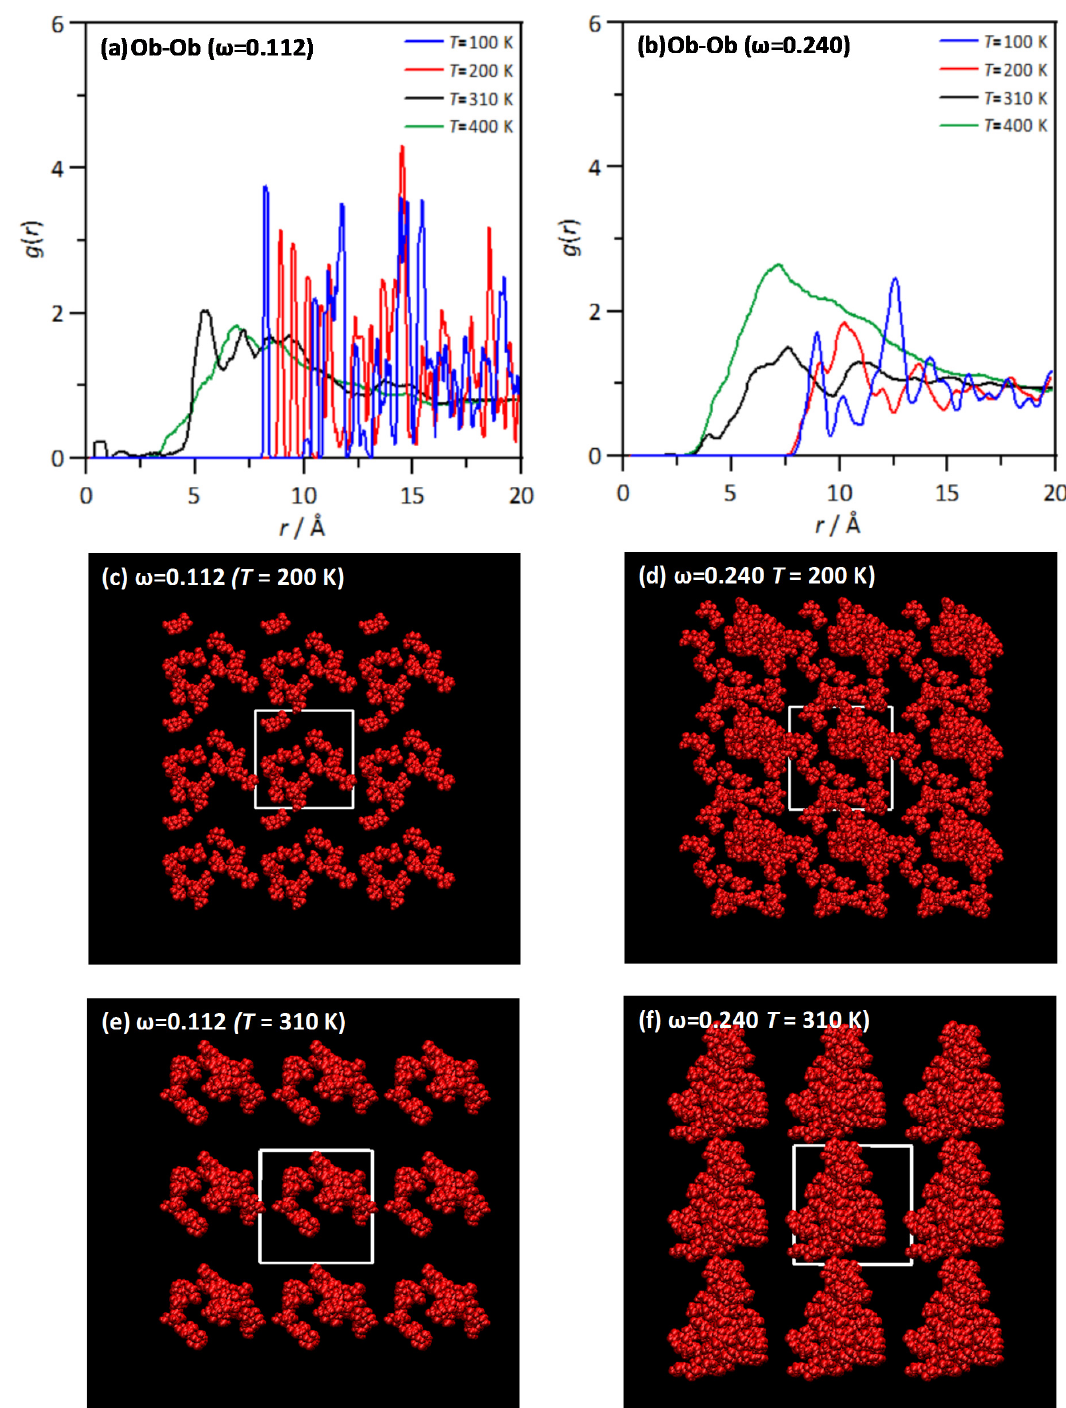
Figure 11. ( a , b ) Site-site radial distribution functions, g ( r ), for the reported atomic pairs in ω THAL + (1- ω ) water mixtures as a function of temperature. ( c, d, e, f ) Snapshots, after 20 ns simulations, of distribution of THAL molecules at selected temperatures for the reported mixtures’ composition, with water molecules omitted for the sake of visibility. In panels ( c , d , e , f ) white lines indicate periodic boundary conditions, THAL molecules are replicated outside the simulated region (white lines) for showing periodicity of THAL aggregation. Atom labelling as in Figure 1.